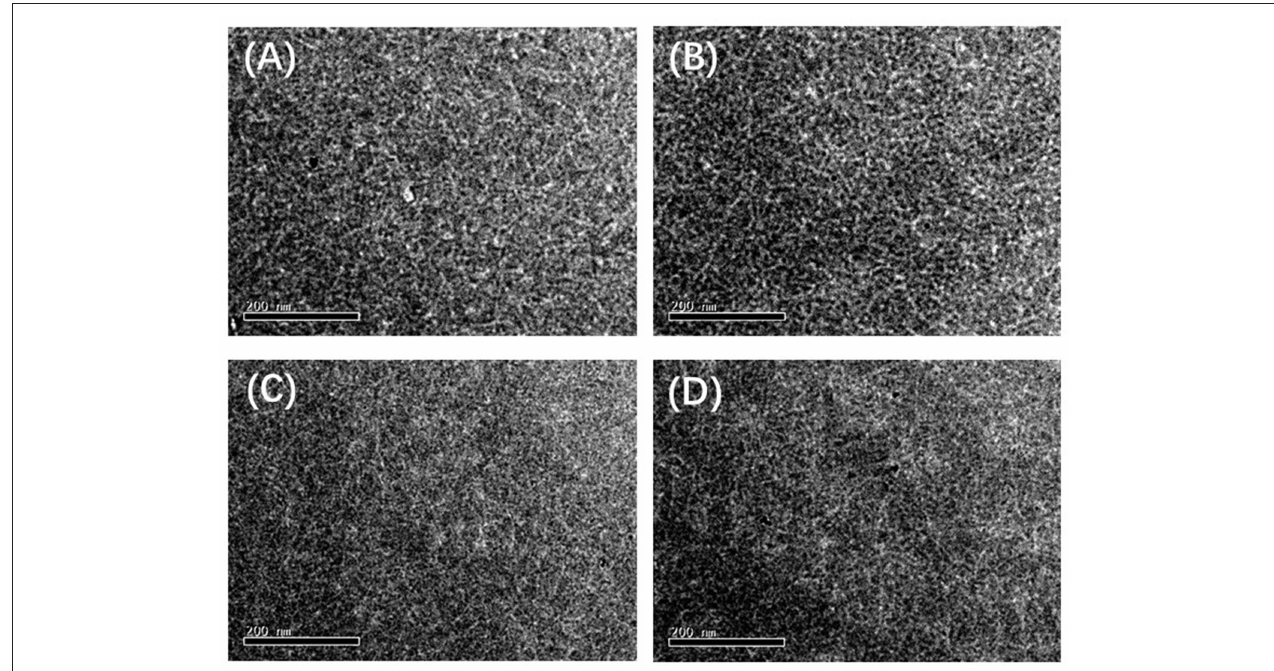
FIGURE 4 | TEM images of the blend films based on the polymer (A) PFCFB, (B) PCFB, (C) PFCB, and (D) PCB